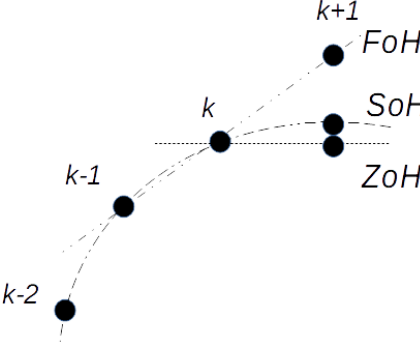
Figure 12. Different kinds of